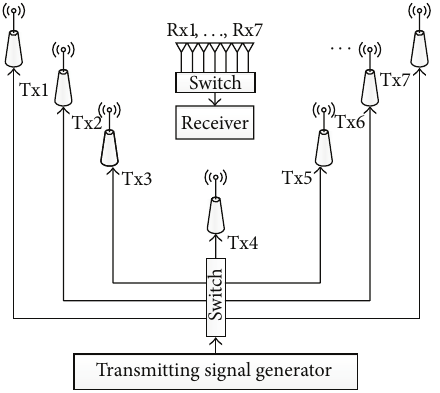
Figure 1: D-MIMO measurement system.